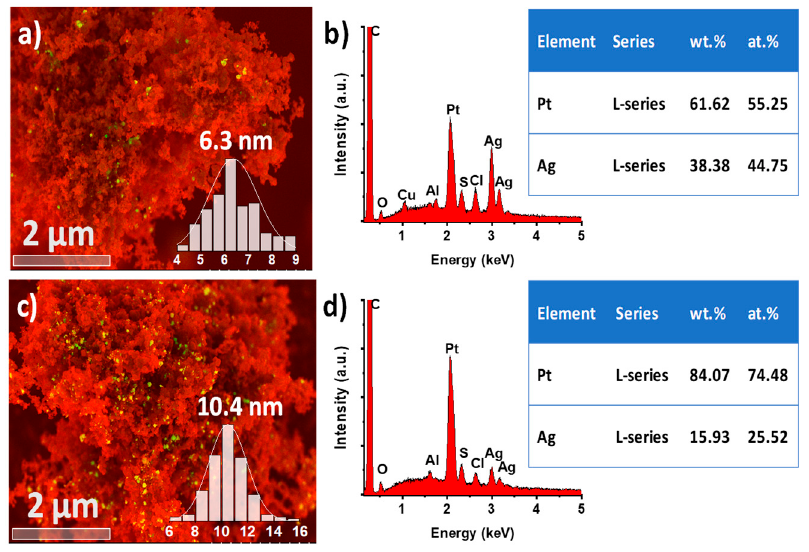
Figure 4. SEM image with its corresponding EDX analysis of ( a ) and ( b ) AgPt (1:1), and ( c ) and ( d ) AgPt (1:3) BNPs.